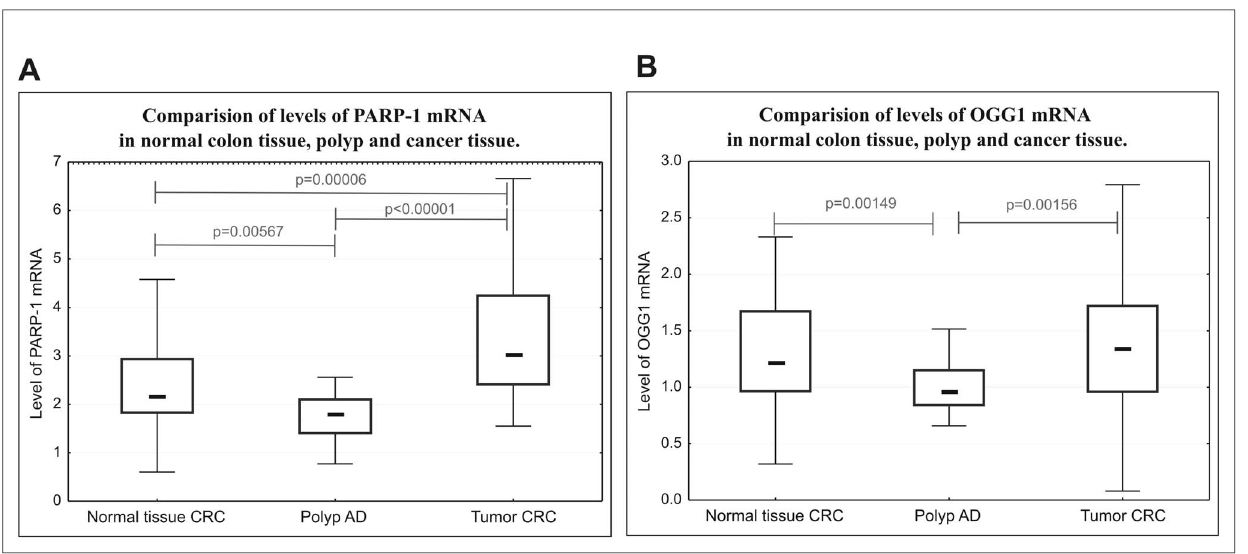
Fig. 1. Level of PARP-1 (A) and OGG1 (B) mRNA in normal colon tissue (n 5 60), polyp (n 5 24) and cancer tissue (n 5 60). Center mark in the box indicates the medians of the samples. The length of each boxes (IQR, interquartile range) represents the range within which the central 50% of the values fell, with the vertical edges placed at the first and third quartiles. Whiskers show variability outside the upper and lower quartiles. P was obtained with the Mann-Whitney